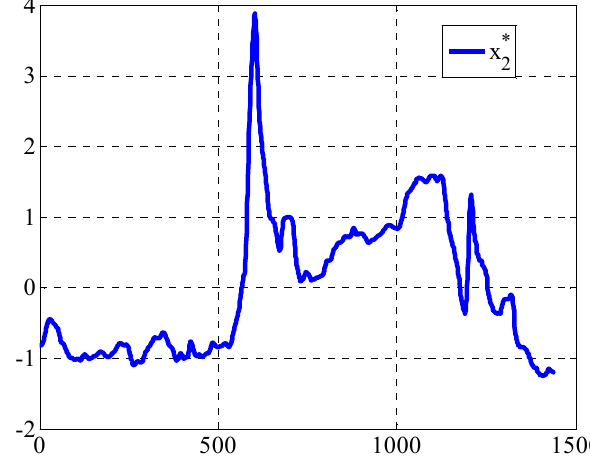
of boiler thermal efficiency (2# boiler). 1 x